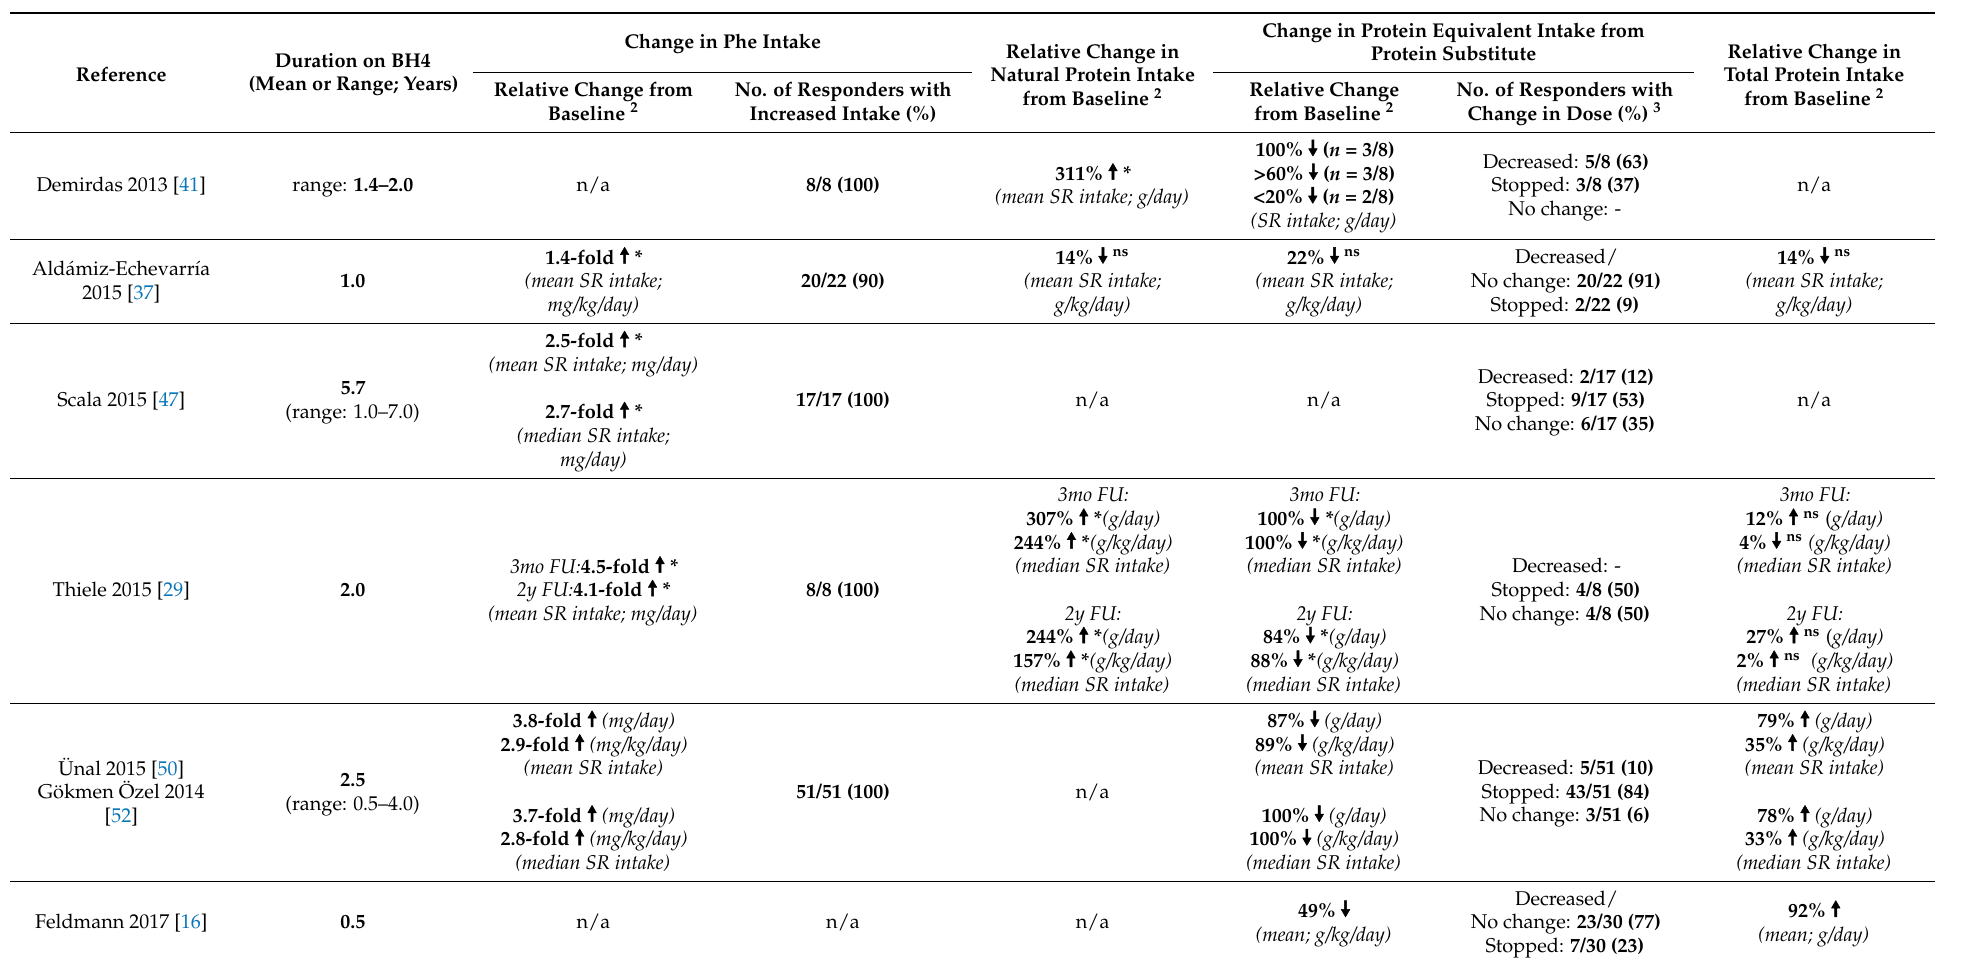
Table 2. Overview of study results: changes in phenylalanine and protein intakes (total protein, natural protein, and protein equivalent from protein substitute) of